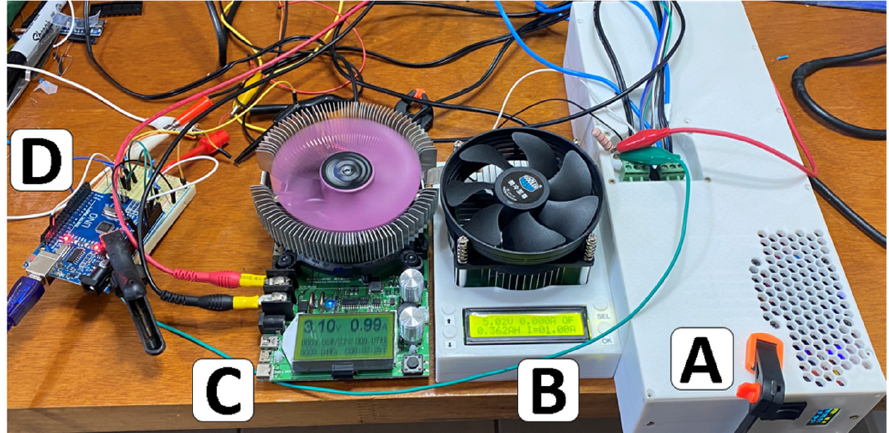
Figure 19. Voltage drop test: A—Power supply, B and C—Electronic load, D—Arduino Uno.